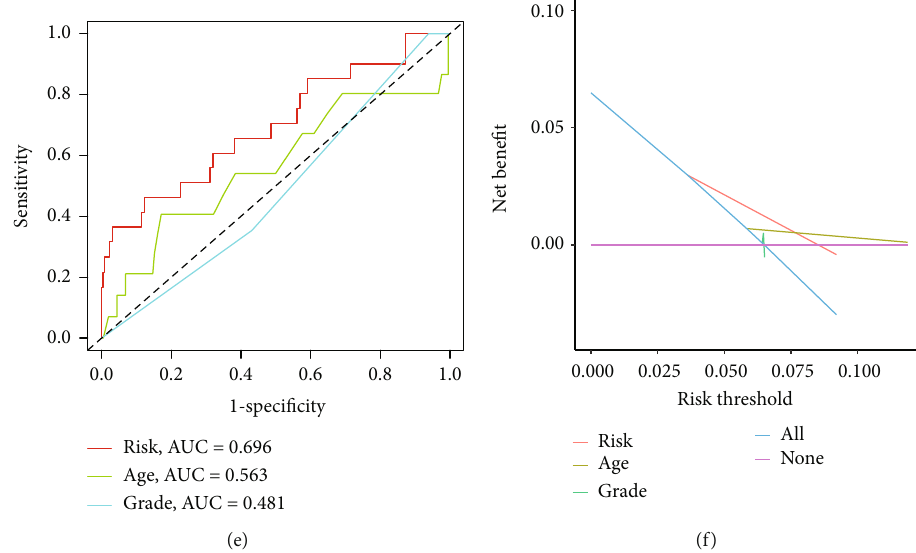
Figure 3: A novel prognostic model based on FAM-related lncRNAs for CC patients. (a) Kaplan-Meier assays revealed that patients in the high-risk group had a considerably shorter overall survival time. (b, c) Risk survival status plot. (d) ROC assays for 1, 3, and 5-year survivals of CC. (e) The AUC values of the risk factors. (f) The DCA of the risk factors.